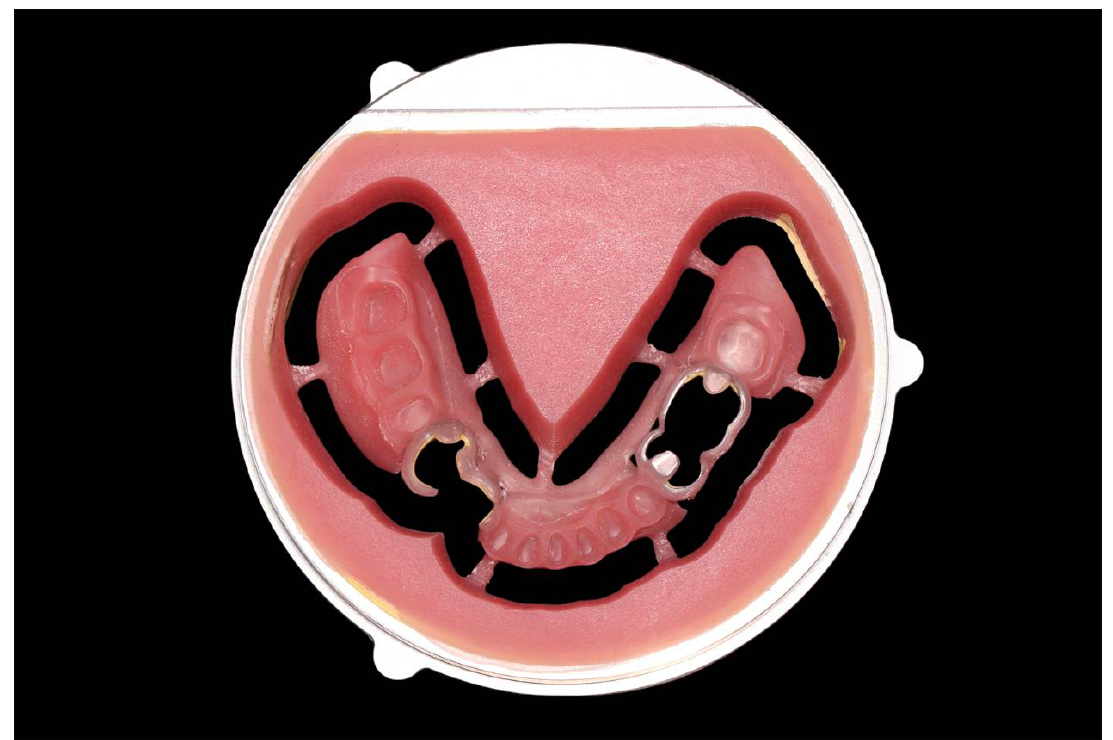
Figure 5. Milled denture base and offset metal structure complex.